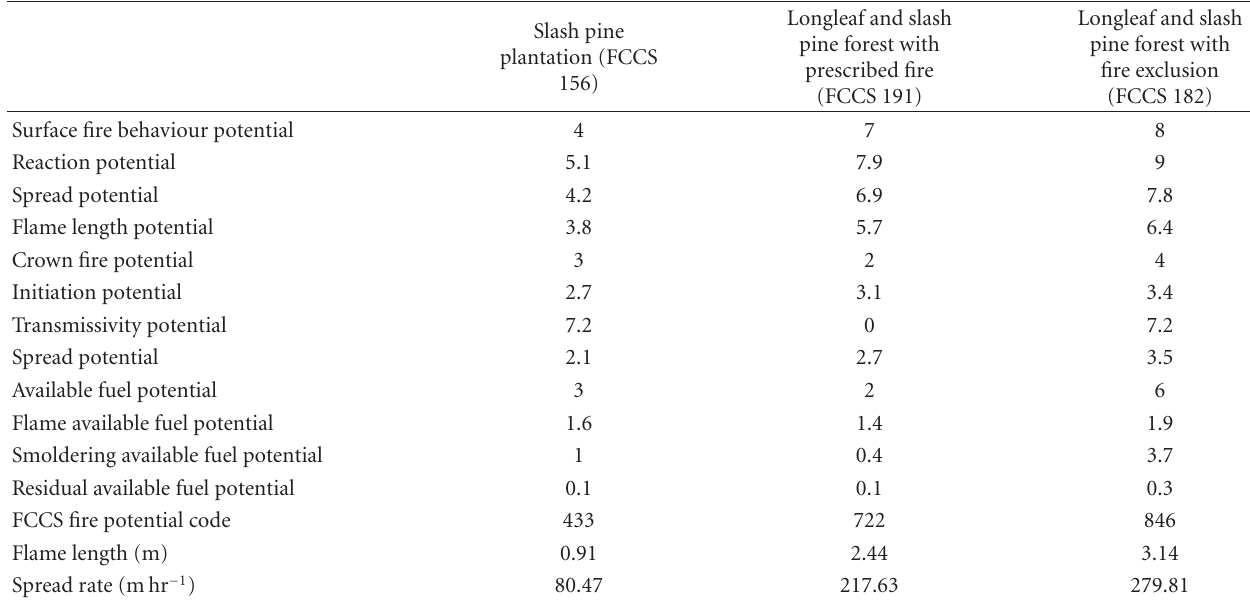
Table 5: FCCS fire behavior potentials for fuelbeds typical of the southeastern United States. FCCS potentials are index